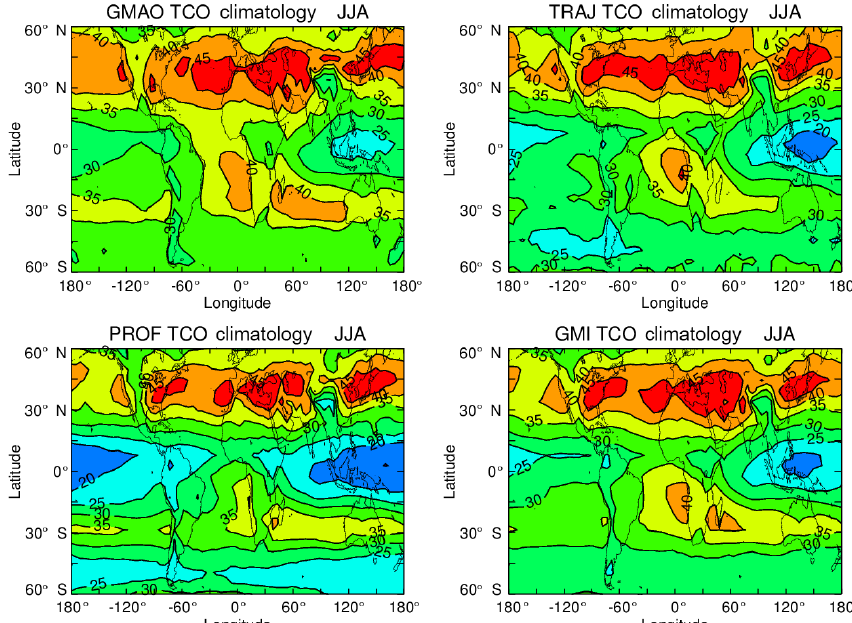
Figure 15. June–July–August (JJA) seasonal climatology of tropospheric column ozone (in Dobson units) for three OMI/MLS products and the Global Modeling Initiative (GMI) chemical transport model. GMAO denotes assimilated OMI/MLS, TRAJ is trajectory-mapped OMI/MLS, and PROF is derived from the OMI-only profile retrieval method of Liu et al. (2010a) and Huang et al. (2017). This figure is from Ziemke et al. (2014) which includes references and detailed descriptions for these three products and the GMI